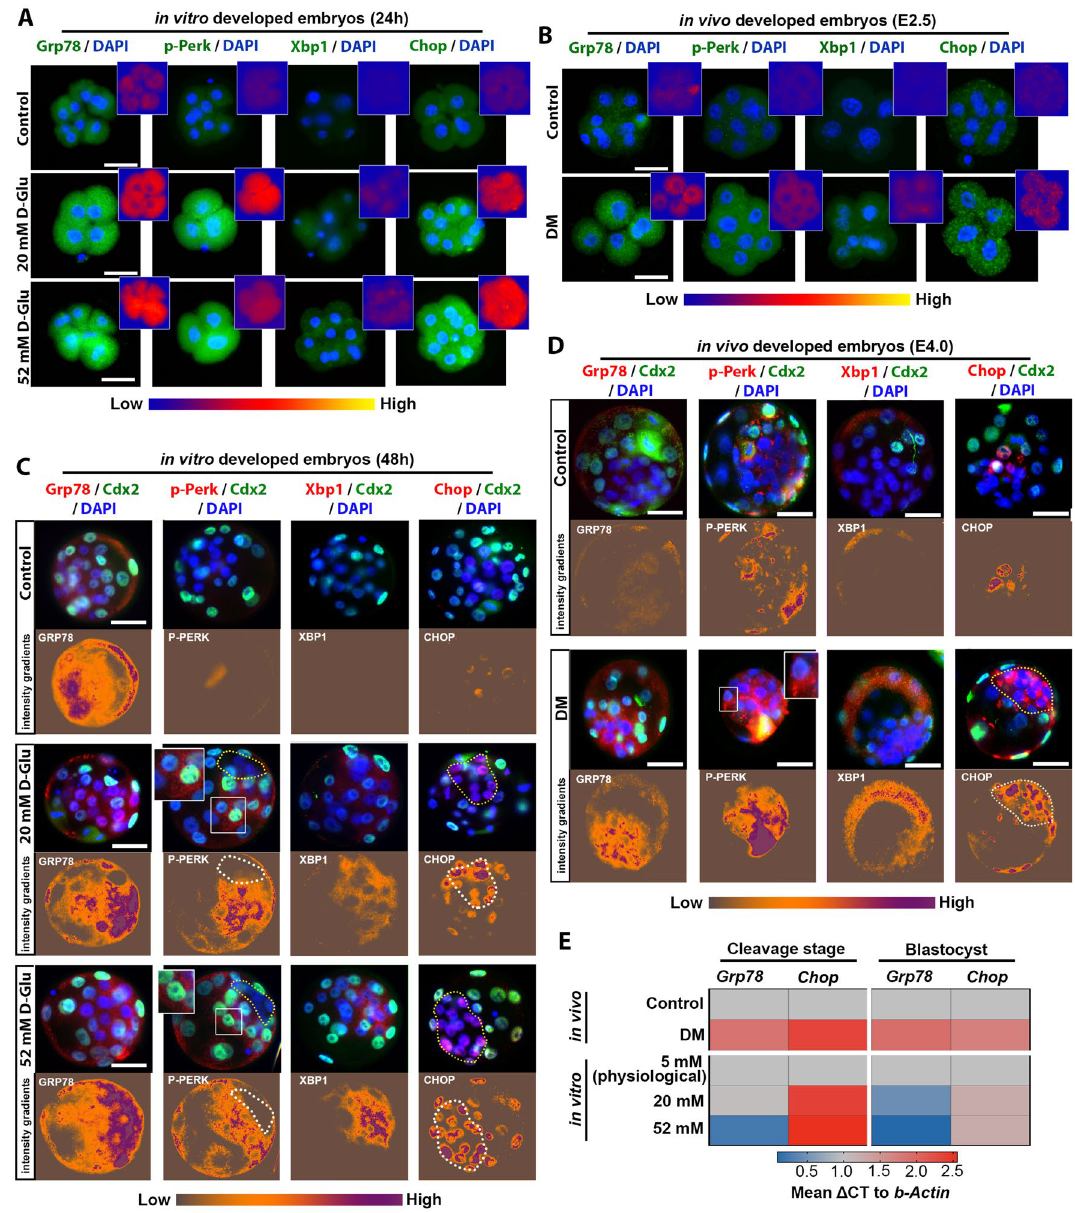
Figure 5. Activation of UPR mechanisms in pre-implantation embryos in response to in vivo and in vitro hyperglycaemic environment. (A,B) The expression of Grp78, p-Perk, Xbp1 and Chop proteins in cleavage stage embryos (at 24 h in vitro culture) in 5 mM (physiological control), 20 mM and 52 mM D-Glucose exposed experimental groups (A) ; and 2.5 days after fertilisation in vivo (B) . Green fluorescent, UPR proteins; blue fluorescent, nuclear DAPI labelling. Insets show Grp78, p-Perk, Xbp1 and Chop expression as an intensity gradient map. Scale bars = 50 µm. At least 5 embryos analysed per group. ( C,D) Double immunofluorescence staining for of Grp78, p-Perk, Chop and Xbp1 in embryos progressed through blastocyst stage in vitro at 48 h (C) and in vivo 4 days after fertilisation (D) . Red fluorescent, UPR proteins; green fluorescent TE layer marker Cdx2; blue fluorescent, nuclear DAPI labeling. Images below show Grp78, p-Perk, Xbp1 and Chop expression as an intensity gradient map. Yellow and white dashed lines demarcate ICM. Scale bars = 50 µm. At least 5 embryos analysed per group. ( E) Heat map of Grp78 and Chop genes detected by qRT-PCR in embryos from control and diabetic experimental groups (cleavage stage embryos collected at 24 h in vitro or E2.5 in vivo; blastocyst stage embryos collected at 48 h in vitro or E4.0 in vivo). △△ Ct quantification is performed (numbers represent fold change difference). n = 30 embryos pooled over 3 independent experiments per sample. Beta Actin used as internal control. Blue and red indicate downregulation and upregulation,